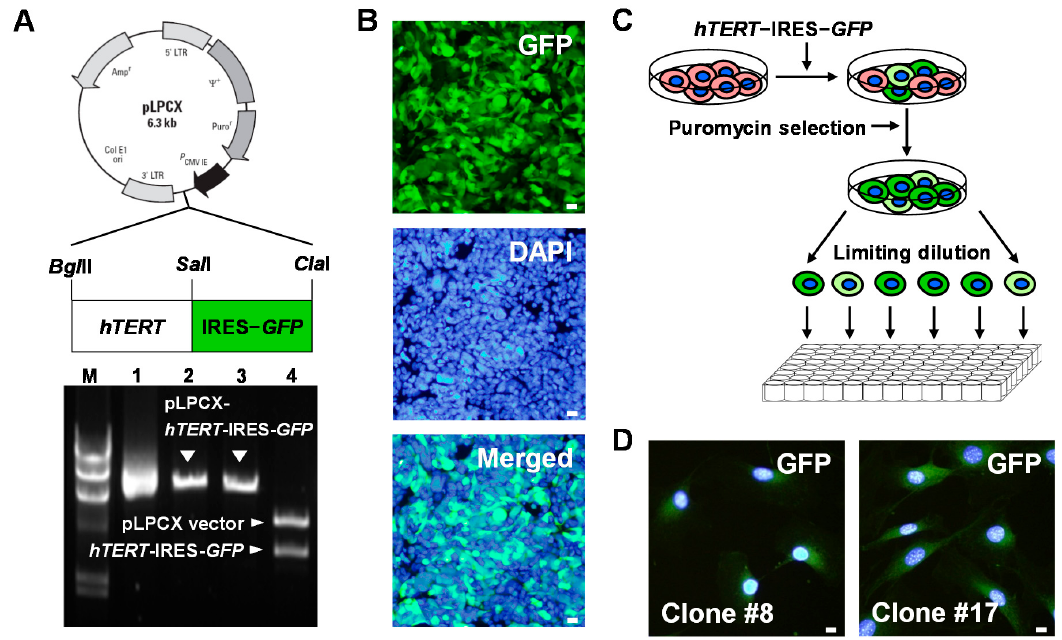
Figure 2. Establishment of hTERT -immortalized Sca-1+ CSC lines. ( A ) Schematic structure